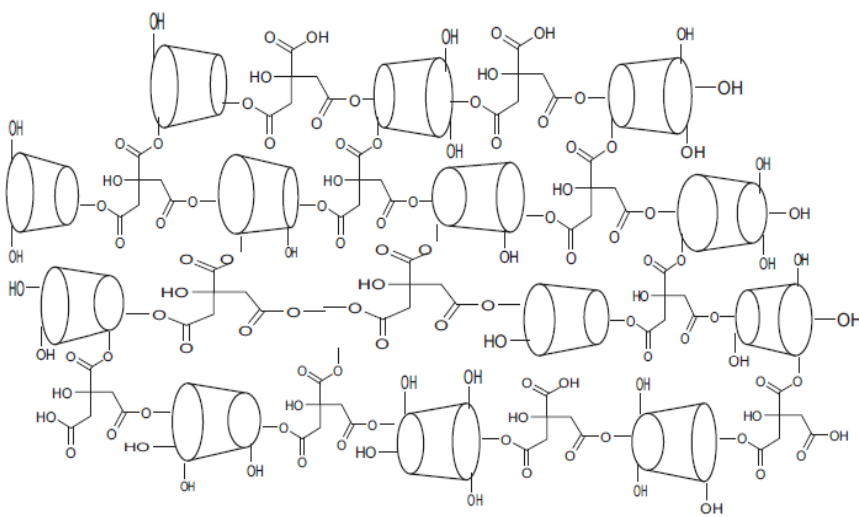
Figure 2. Cross-linked structure of cyclodextrin polymer.